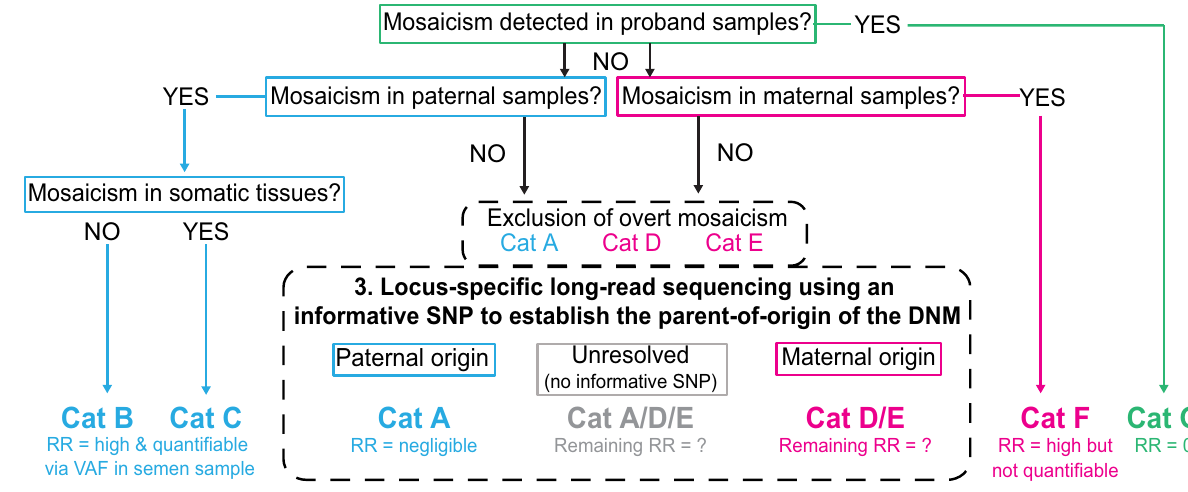
Fig. 2 | Flow chart describing the three-tier sample analysis in the PREGCARE study. Following collection of up to 14 different biological samples per family and veri fi cation of the familial relationships between the 3 individuals of the trio, the DNM site was deep-sequenced in all family samples (performed in triplicate reac- tionstogetherwith3unrelatedcontrols)todetectlowlevelsofparentalmosaicism